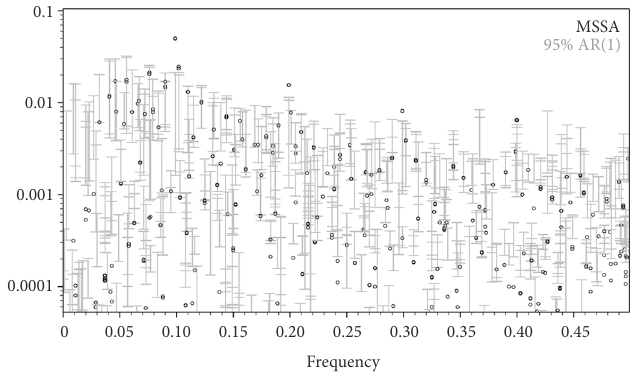
Figure 2. Oscillatory behavior (cycle) in the UK financial series 1270–2016 (source: Authors’ calculation)